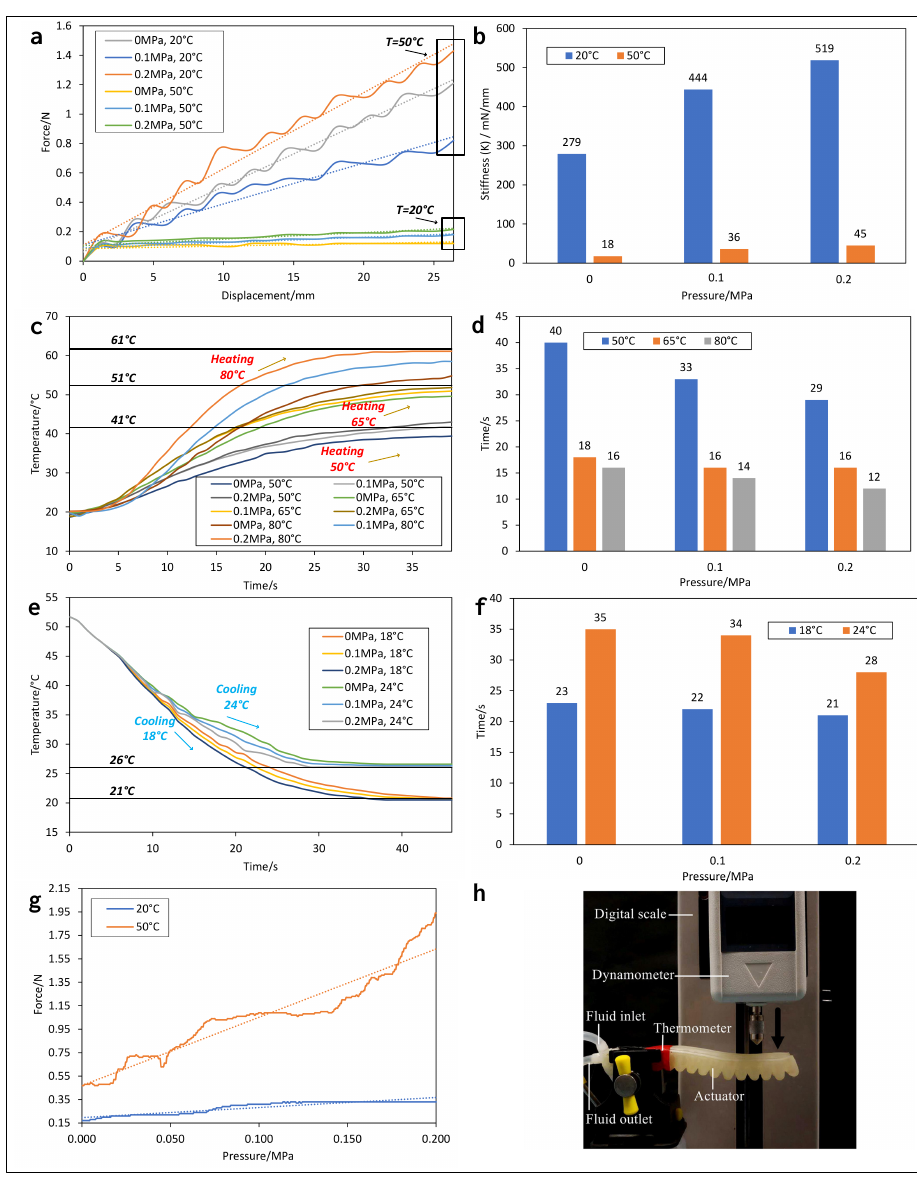
Figure 7. Testing the stiffness variations, temperature variations, and output force of the actuator. ( a ) Output force of the actuator during displacement at different temperature (20–50 ◦ C) and pressure (0–0.2 MPa) of the input fluid. ( b ) Stiffness variation of the actuator at different temperature (20–50 ◦ C) and pressure (0–0.2 MPa) of the input fluid. ( c ) Dynamic change in the temperature of the actuator at different temperature (50–80 ◦ C) and pressure (0–0.2 MPa) of the input fluid. ( d ) Time required by the actuator to reach 50 ◦ C at different temperatures (50–80 ◦ C) and pressures (0–0.2 MPa) of the input fluid. ( e ) Dynamic change in the temperature of the actuator at different temperatures (18–24 ◦ C) and pressures (0–0.2 MPa) of the input fluid. ( f ) Time required by the actuator to reach 20 ◦ C at different temperatures (18–24 ◦ C) and pressures (0–0.2 MPa) of the input fluid. ( g ) Output force of the actuator at different temperatures (20–50 ◦ C) and pressures (0–0.2 MPa) of the input fluid. ( h ) An optical photo showing the set-up utilized to perform the stiffness test of the